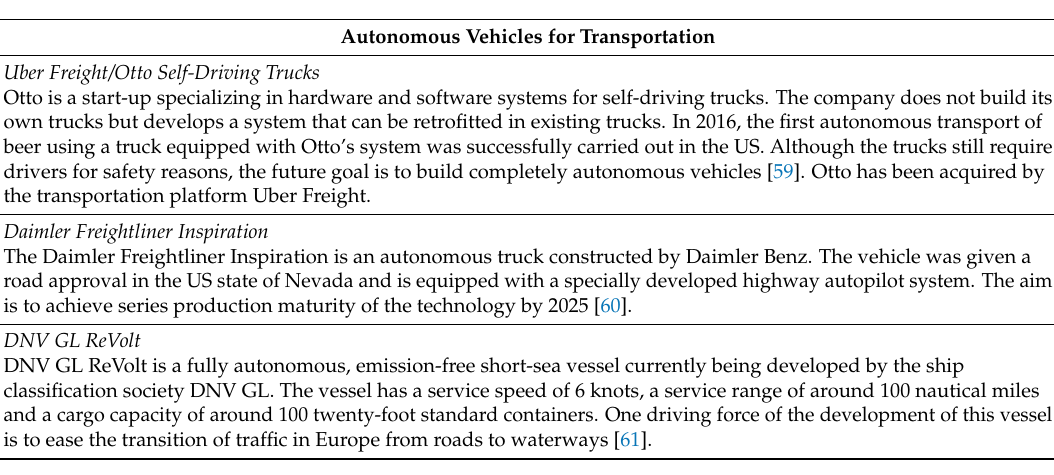
Table 2. Practical examples of autonomous transportation vehicles.